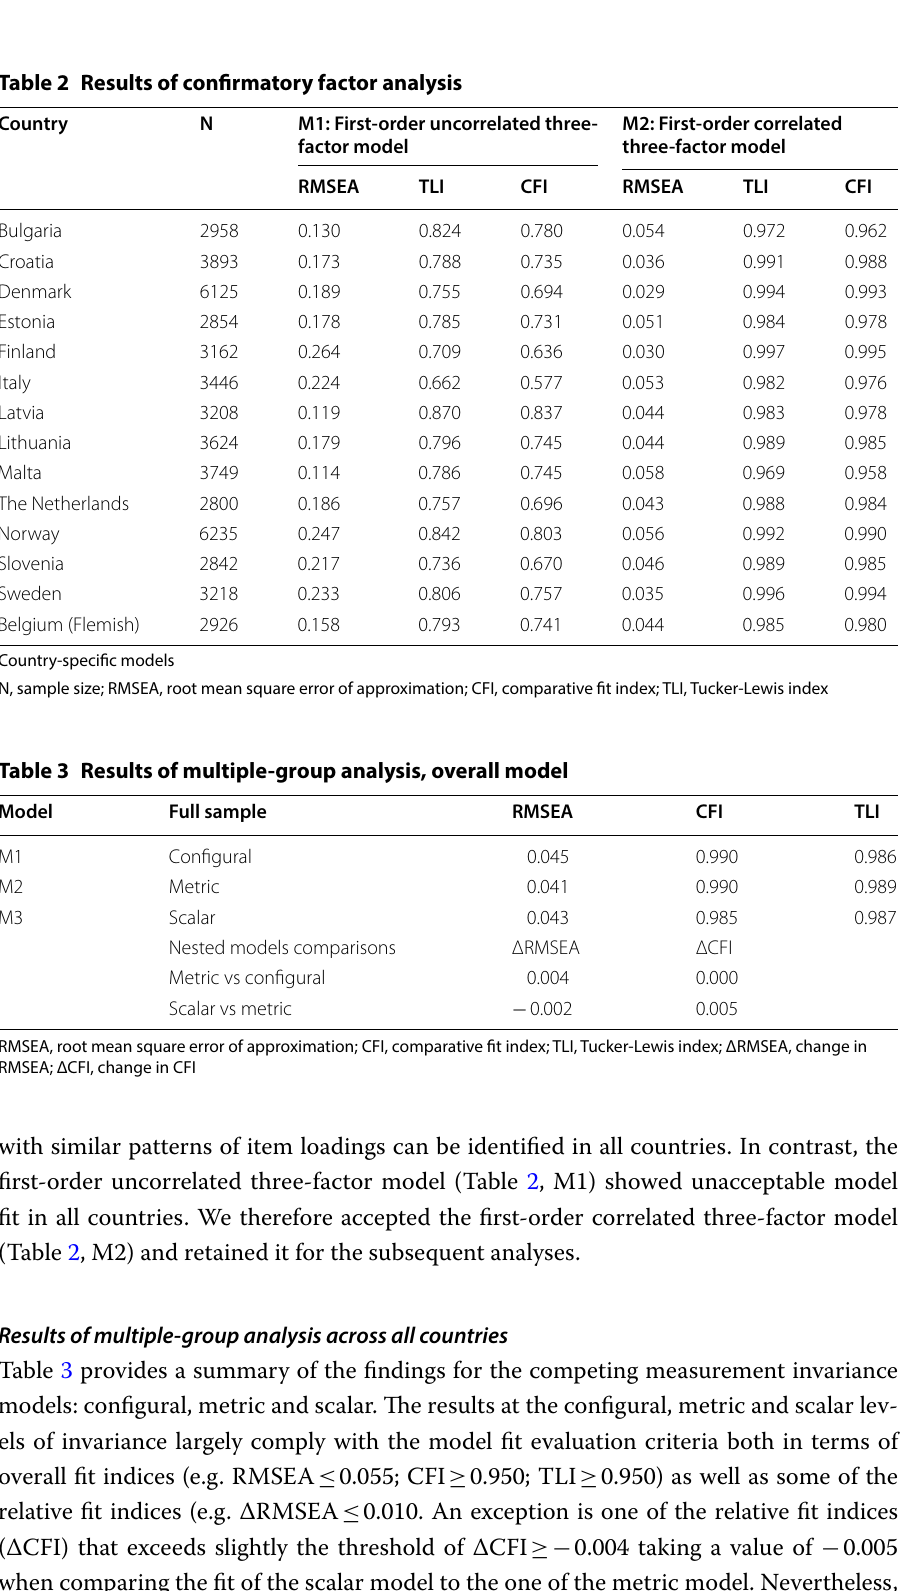
Table 2 Results of confirmatory factor analysis